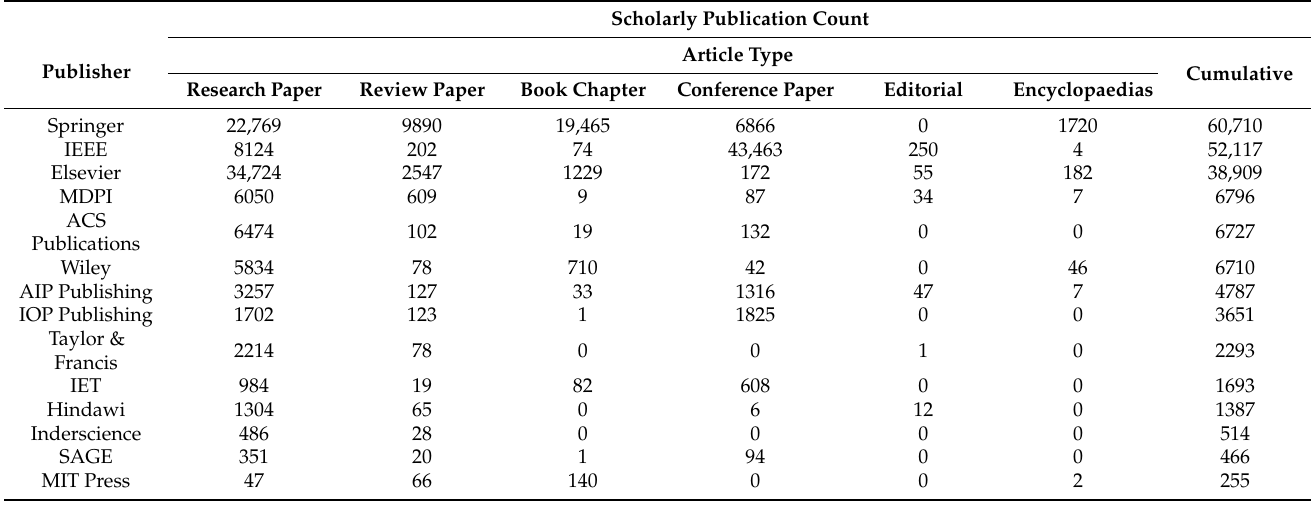
Table 2. Publisher’s publication count for specific article type. Table 2. Publisher ’ s publication count for specific article type.